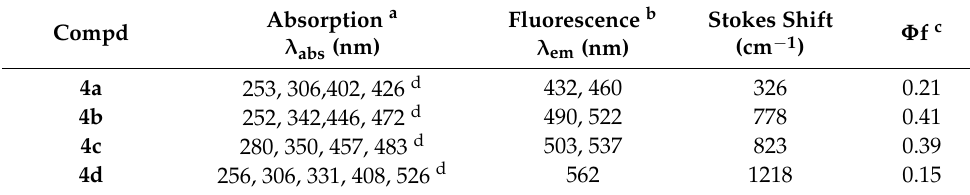
Table 1. Optical properties of products.